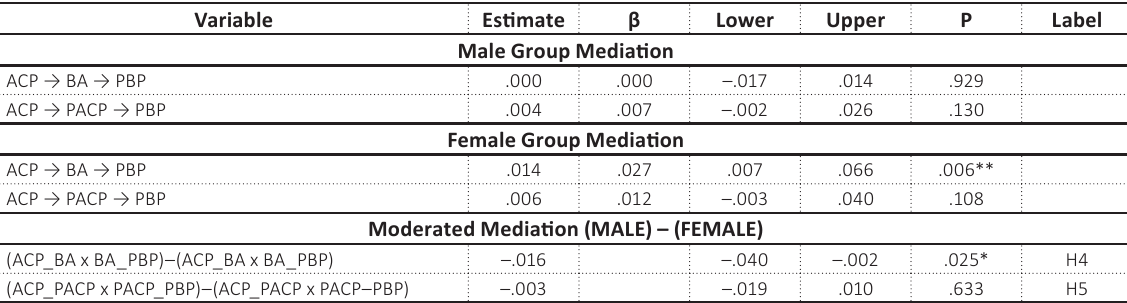
Table 5. Gender moderated mediation effects Variable Estimate